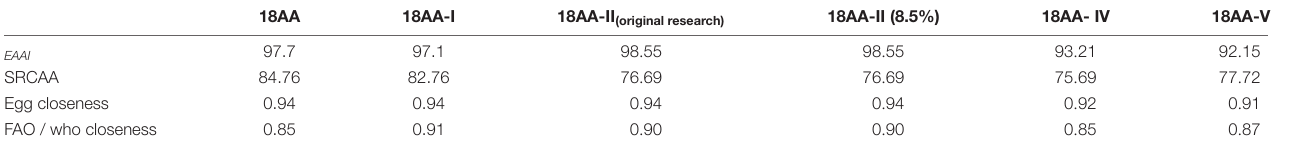
TABLE 5 | EAAI, SRCAA, and closeness of 18AA-II original research and five formulations of amino acids for injection to the standard